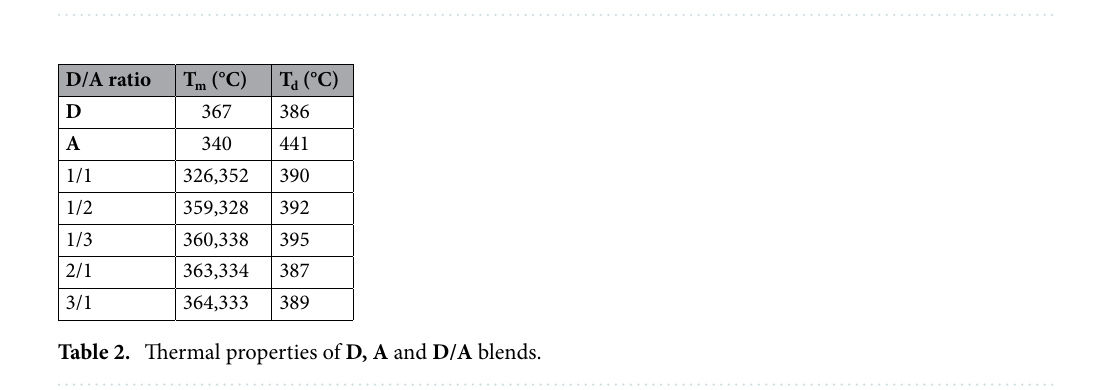
Figure 4. DSC thermograms of pristine D , A and D/A blends. Graph was plotted using Origin software (https ://www.origi nlab.com/, version: 8.5).